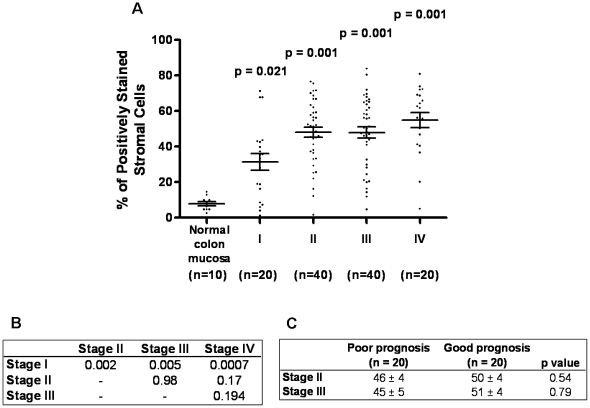
Correlation between SPARC expression and AJCC disease staging.(A) Percentage of positively stained cells in AJCC stage I, II, III and IV CRCs compared to normal colonic tissue (Con). SPARC expression was significantly greater in CRC compared to control. There was a significantly greater number of SPARC positive cells in stage II, III and IV CRC compared to stage I (p = 0.092, p = 0.005 and p = 0.0007 respectively). Data presented as a scatter plot with the mean ± SEM. (B) P values comparing the percentage of SPARC positive cells in stage I, II, III and IV CRC. (C) P values comparing SPARC expression in stage II to III good and poor outcome CRC. No differences in SPARC levels between good and poor stage II CRC or good and poor stage III CRC. Data expressed as a percentage of positively stained cells ± SEM.